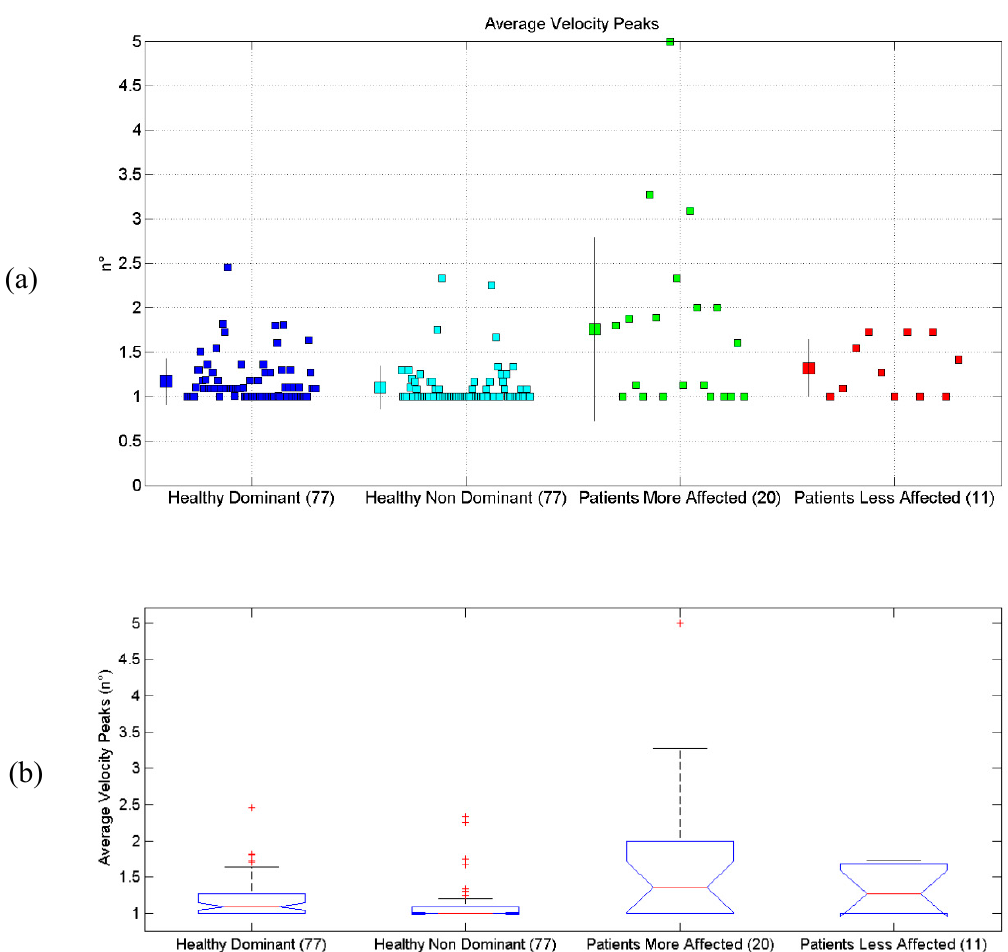
Figure 9. ( a ) Scatterplot for the Average Number of Velocity Peaks for the four considered groups. Mean (SD) of each population (considered limb) are reported. ( b ) Distributions of the Average Number of Velocity Peaks, are shown for the four experimental conditions. The central line indicates the median, while the lower and upper extremities of the boxes represent the 25th and 75th percentiles, respectively. The whiskers comprise all data points of distribution except the outliers, which are plotted separately using the ‘+’ mark.